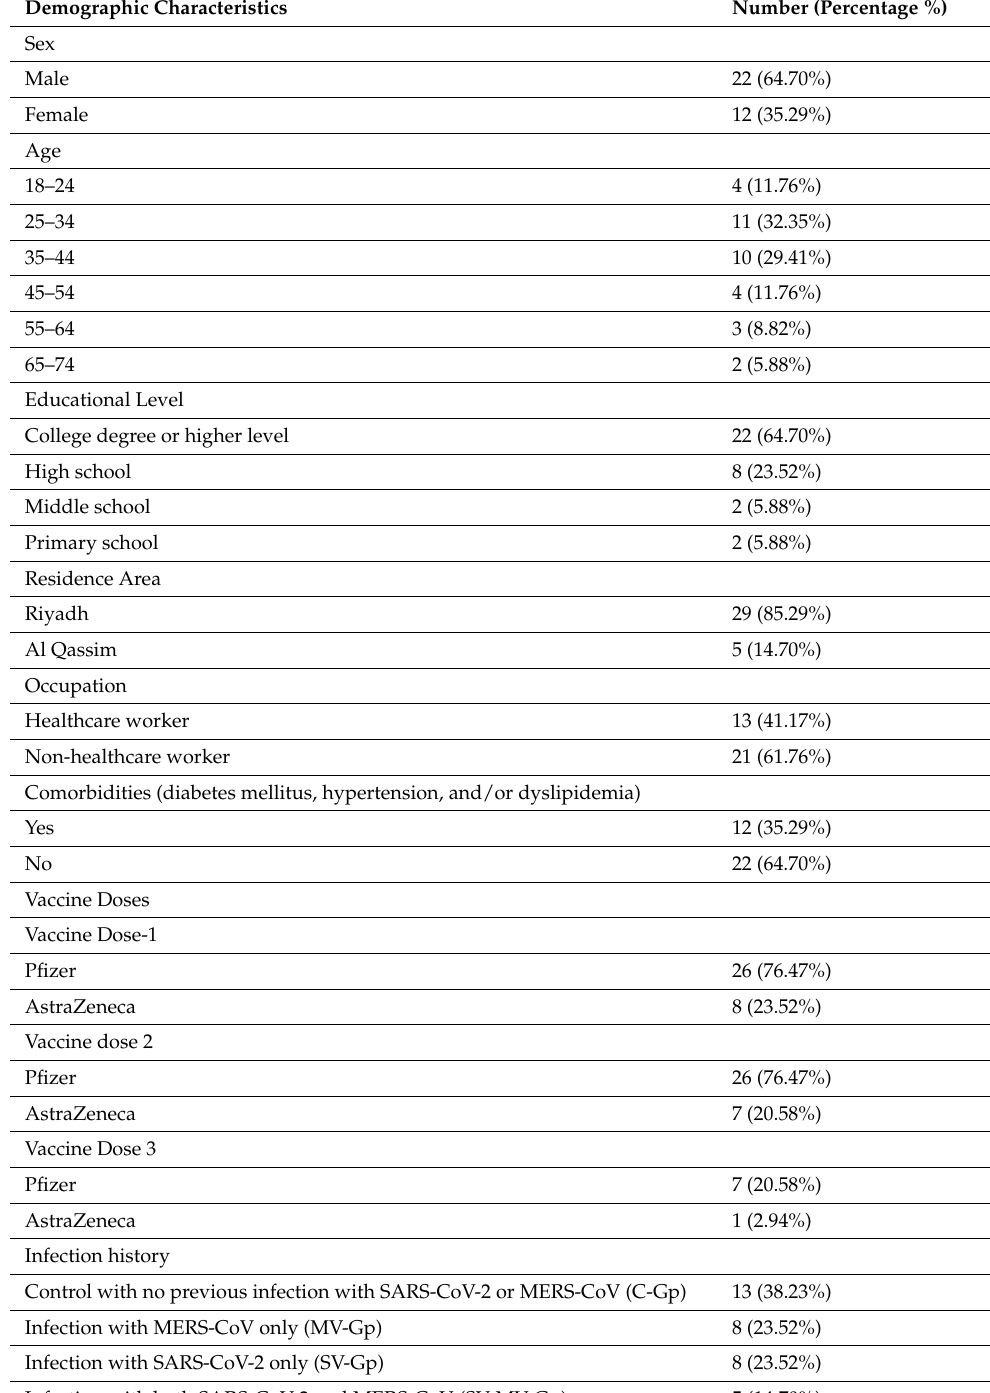
Table 1. The demographic characteristics of the participants (n =